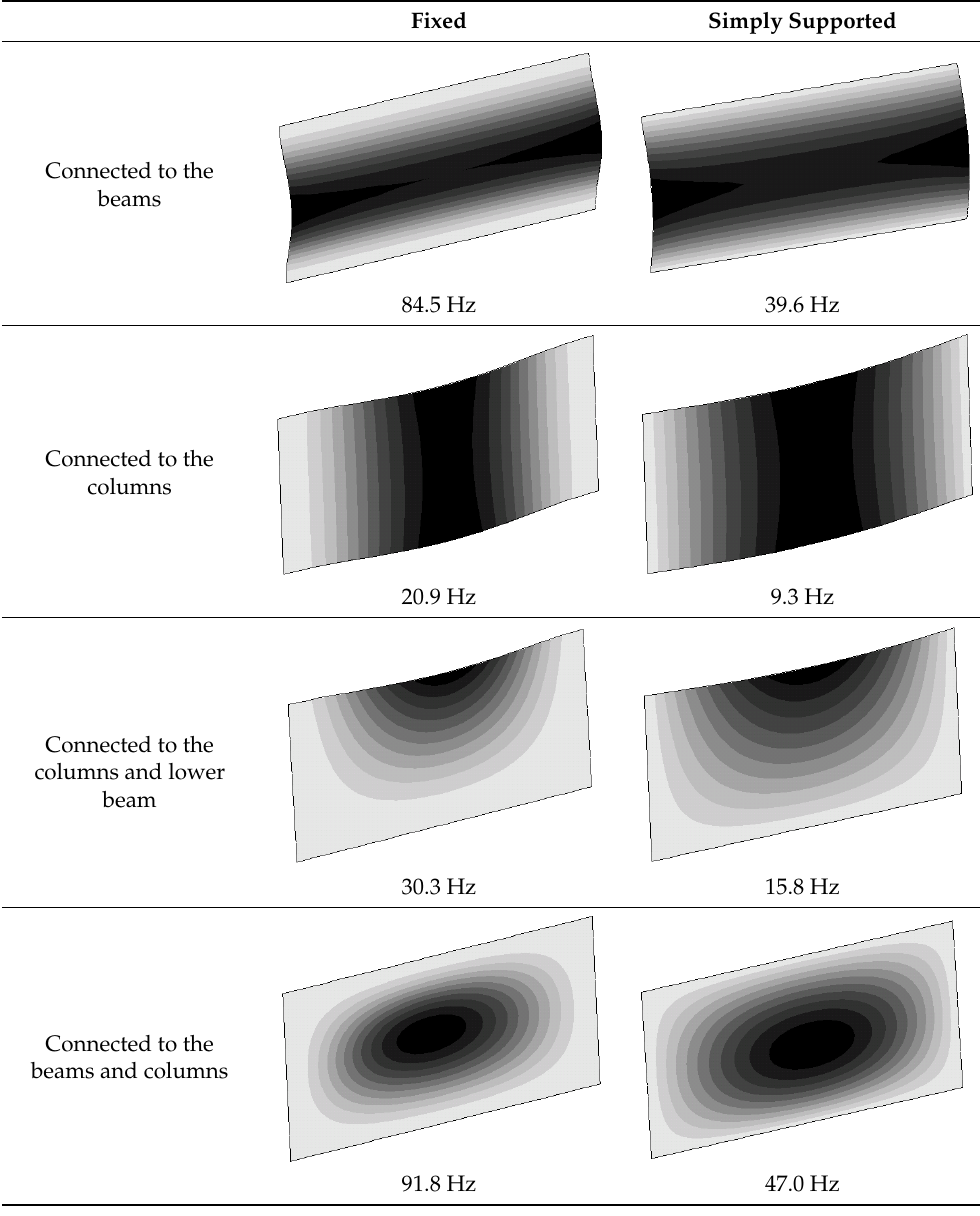
Table 9. Numerical frequencies of the solid wall of models 2 and 3 (South facade) for different support conditions.